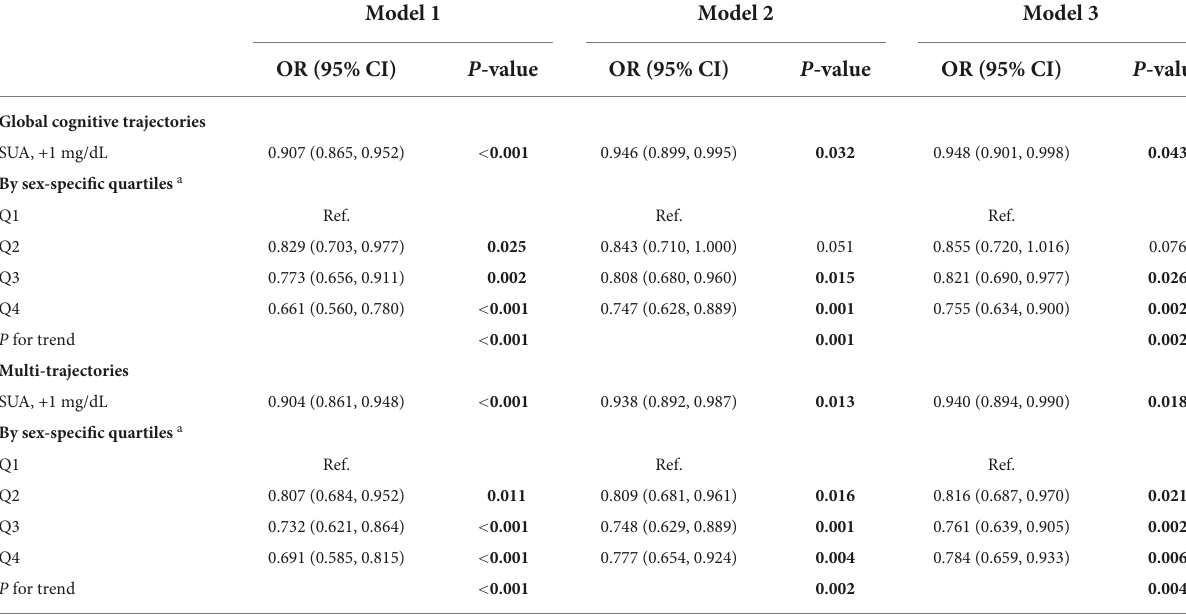
TABLE 2 Associations between baseline SUA and risk of poorer cognitive